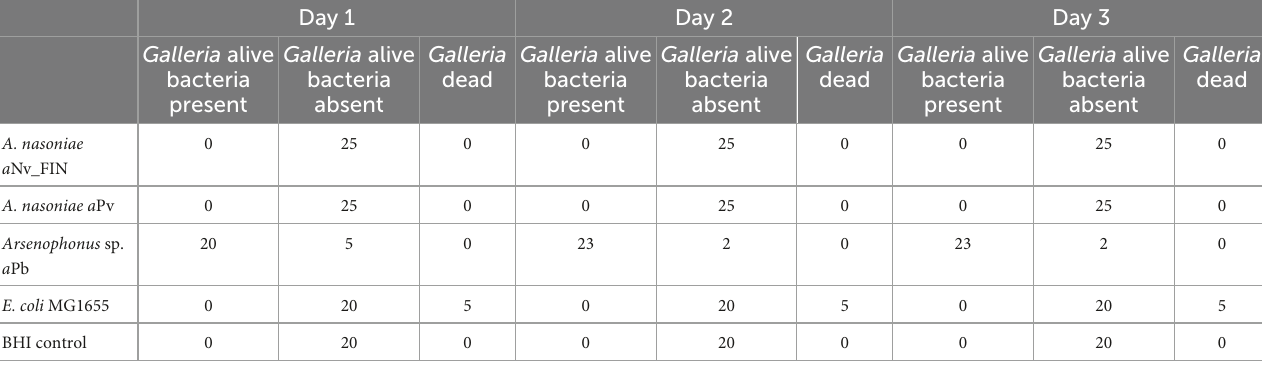
TABLE 3 Alive/dead status of G. mellonella waxworm larvae, and presence of microbial proliferation as scored through GFP fluorescence status of the waxworm, over 3 days post-injection with various strains of Arsenophonus , with E. coli MG1655 known to be not capable of proliferation, and BHI medium injection as